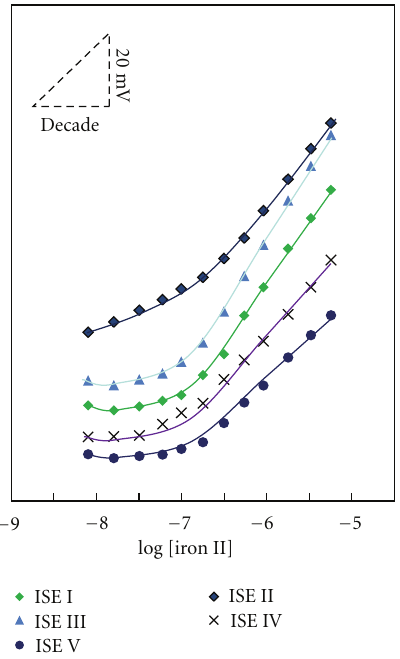
Figure 3: Calibration curve in acetate bu ff er at pH 4.7 for di ff erent